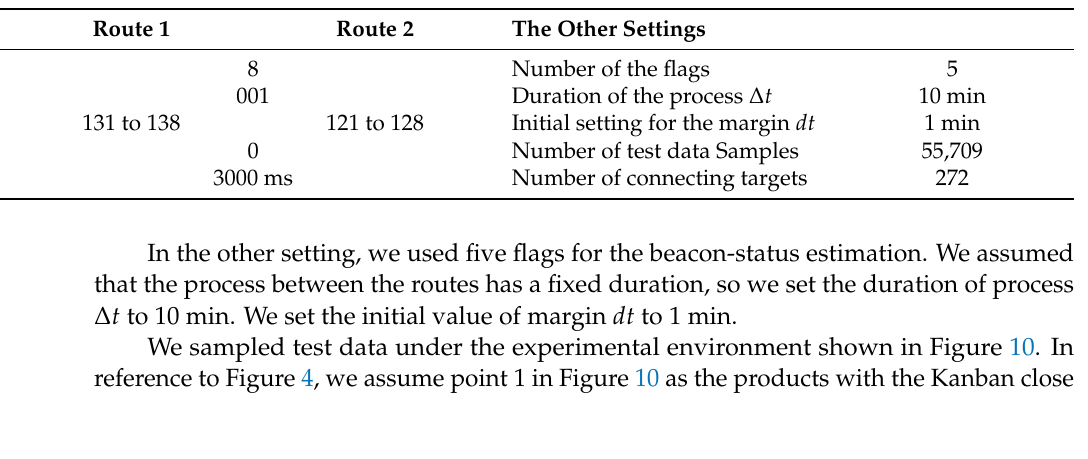
Table 1. Summary of experimental